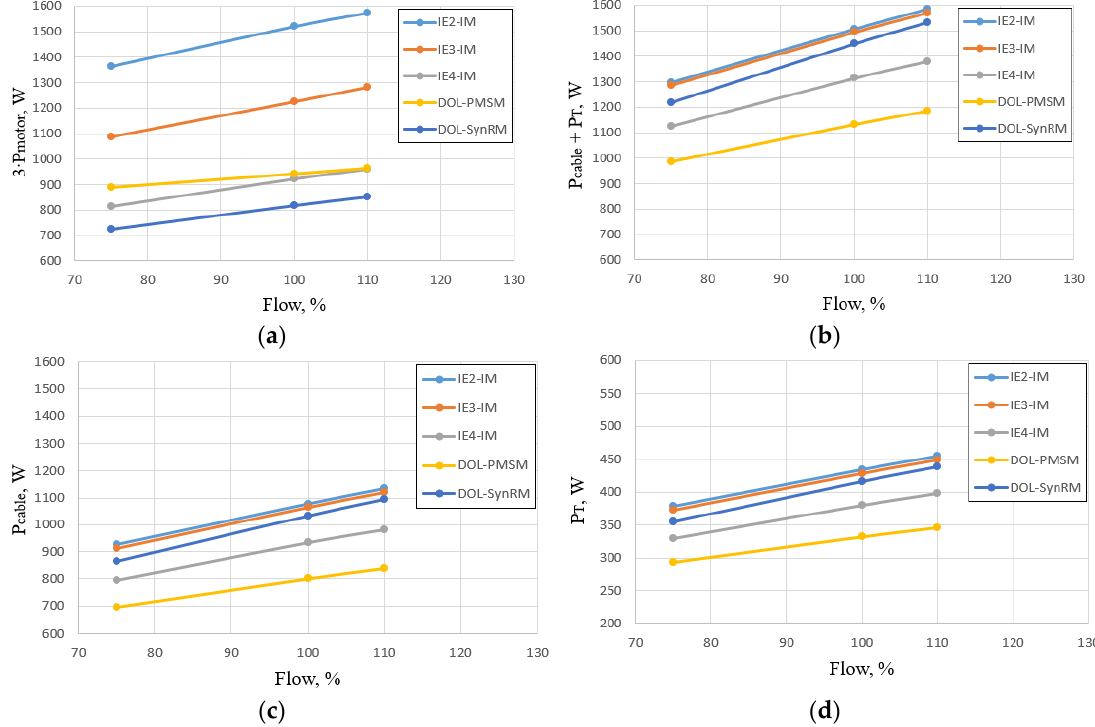
Figure 7. Power losses at three points of the pump duty cycle with various flows: ( a ) motors; ( b ) cable + transformer; ( c ) cable; ( d ) transformer.